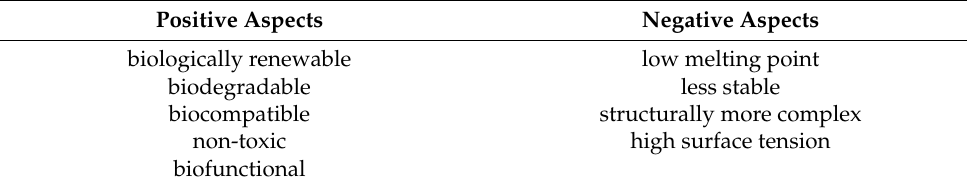
Table 1. The positive and negative aspects of natural biopolymers.